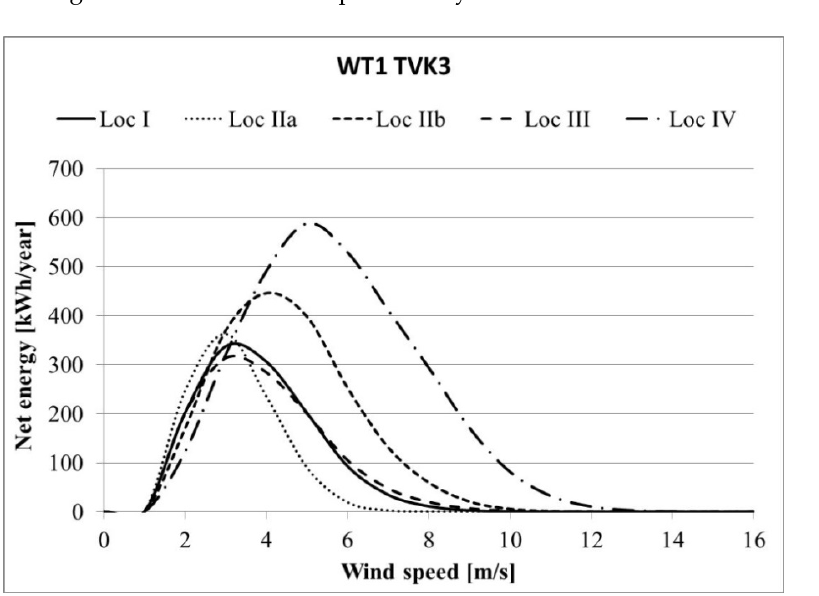
Figure 11. Amount of energy supplied to the power grid by the wind turbine as a function of the wind speed—WT1.